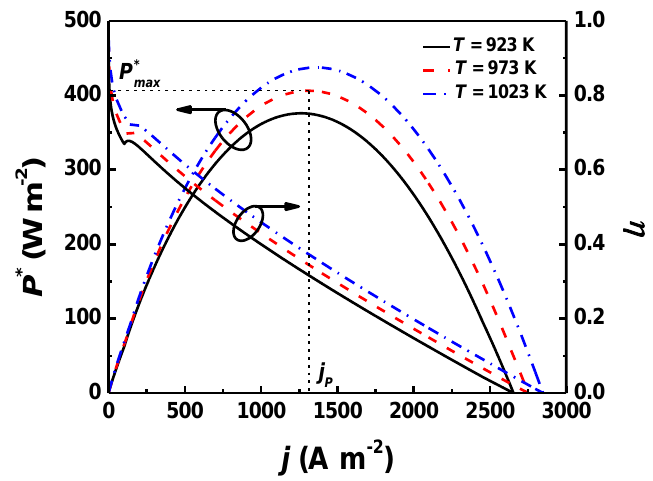
Figure 5. Effects of operating temperature T on the hybrid system performance.